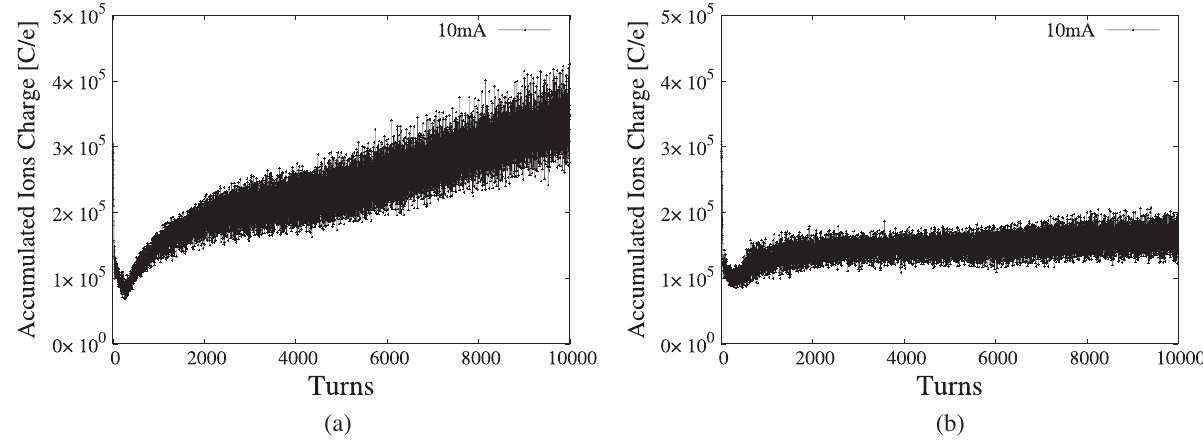
FIG. 4. The total ion charge accumulated at the interaction point as a function of the tracking turns in the weak-strong simulation without (left) and with (right) synchrotron radiation damping and quantum